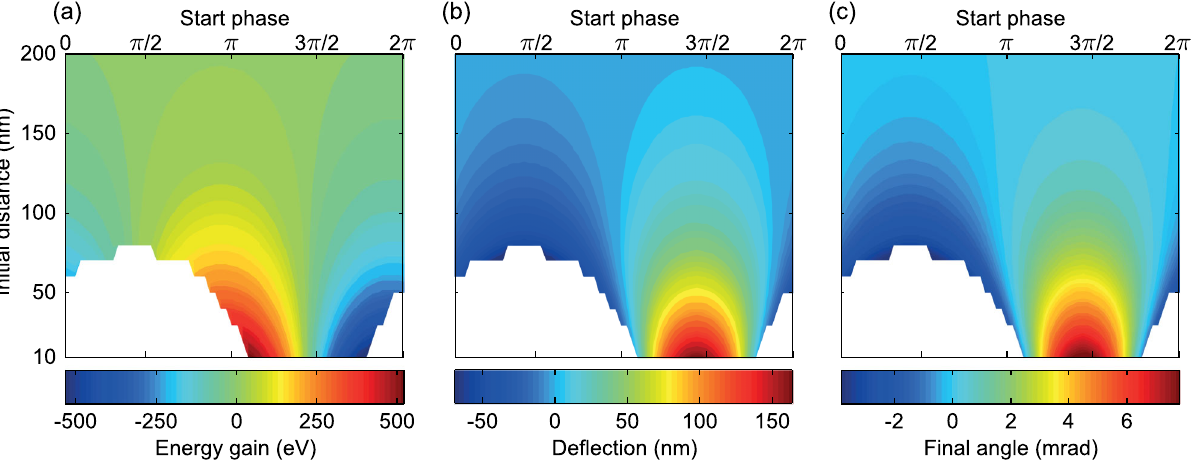
FIG. 8 (color online). Particle tracking results of a single electron interacting with the laser pulses in close proximity of the fused silica grating [Figs. 1(d) and 1(e)]. We use the experimental laser parameters mentioned in the text and a laser peak electric field of E ¼ 2 . 85 GV = m. The initial electron energy is E ¼ 27 : 9 keV ( β ¼ 0 . 32 ), hence electrons interact synchronously with the third p kin spatial harmonic. Color-coded plots show the energy gain Δ E (a), the deflection Δ z (b), and the final angle β z = β x (c) as a function of kin the initial distance z 0 from the grating and the relative start phase between the electron and the laser field. For the white areas the electron crashes into the grating during the simulation. The accelerating and deflecting forces are out of phase, i.e., for the start phase with maximum acceleration the deflection vanishes and vice versa. Note that in our simulation a larger start phase corresponds to a later start time. Therefore, if electrons with a smaller start phase are accelerated less than those with a larger start phase, bunching (focusing in time) takes place. For those start phases [between π = 2 and π in (a)] electrons become deflected towards the